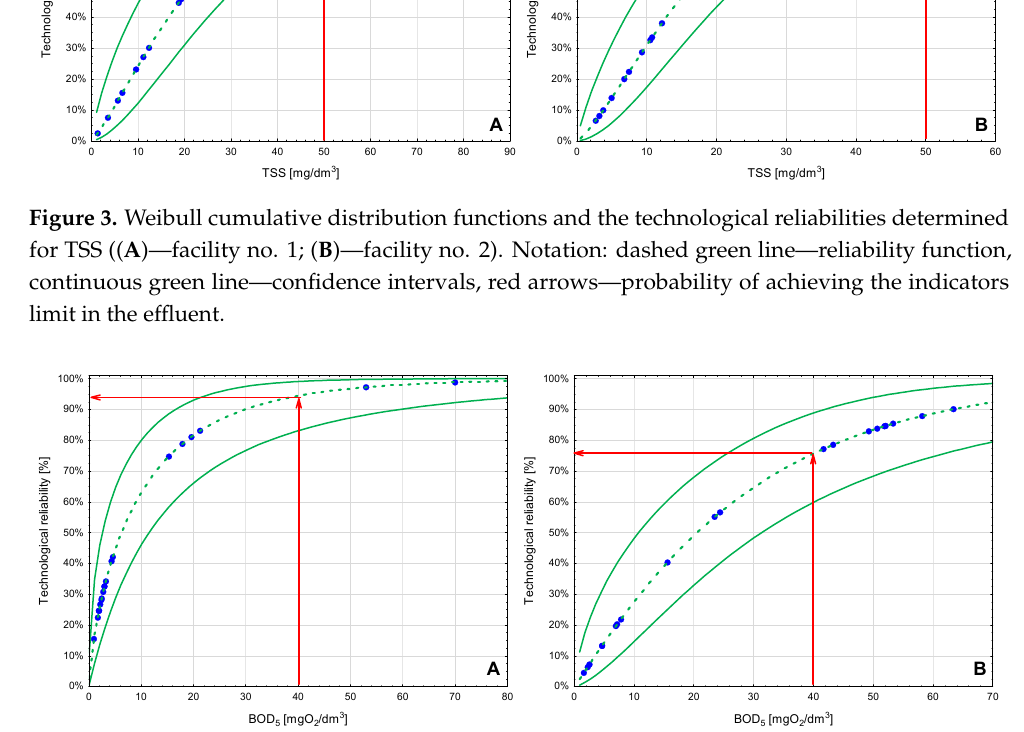
Figure 4. Weibull cumulative distribution functions and the technological reliabilities determined for BOD 5 (( A )—facility no. 1; ( B )—facility no. 2). Notation : dashed green line—reliability function, continuous green line—confidence intervals, red arrows—probability of achieving the indicators limit in the effluent.